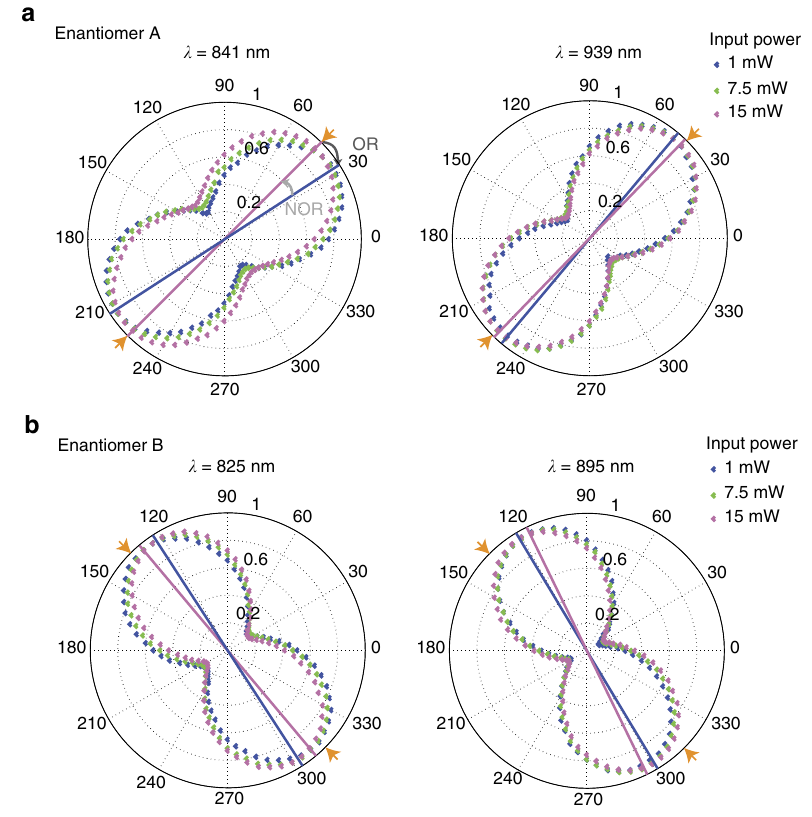
Figure 5 | Intensity-dependent optical rotation. ( a ) Polarization diagrams of transmitted light at varied intensities from enantiomer A. Measurements of the shape of the polarization were obtained at the two resonance locations, l ¼ 841nm and l ¼ 939nm. As the power of the incident light is increased, the elliptical polarizations are rotated. The orange arrowheads indicate the input angle at which the linear polarization was incident on the sample. The blue and purple lines indicate the orientation of the long axis of the elliptical polarization at 1 and 15mW, respectively. ( b ) Polarization diagrams of the output wave from enantiomer B. The diagrams were measured at wavelengths of 825 and 895nm, corresponding to the resonance dips of the second